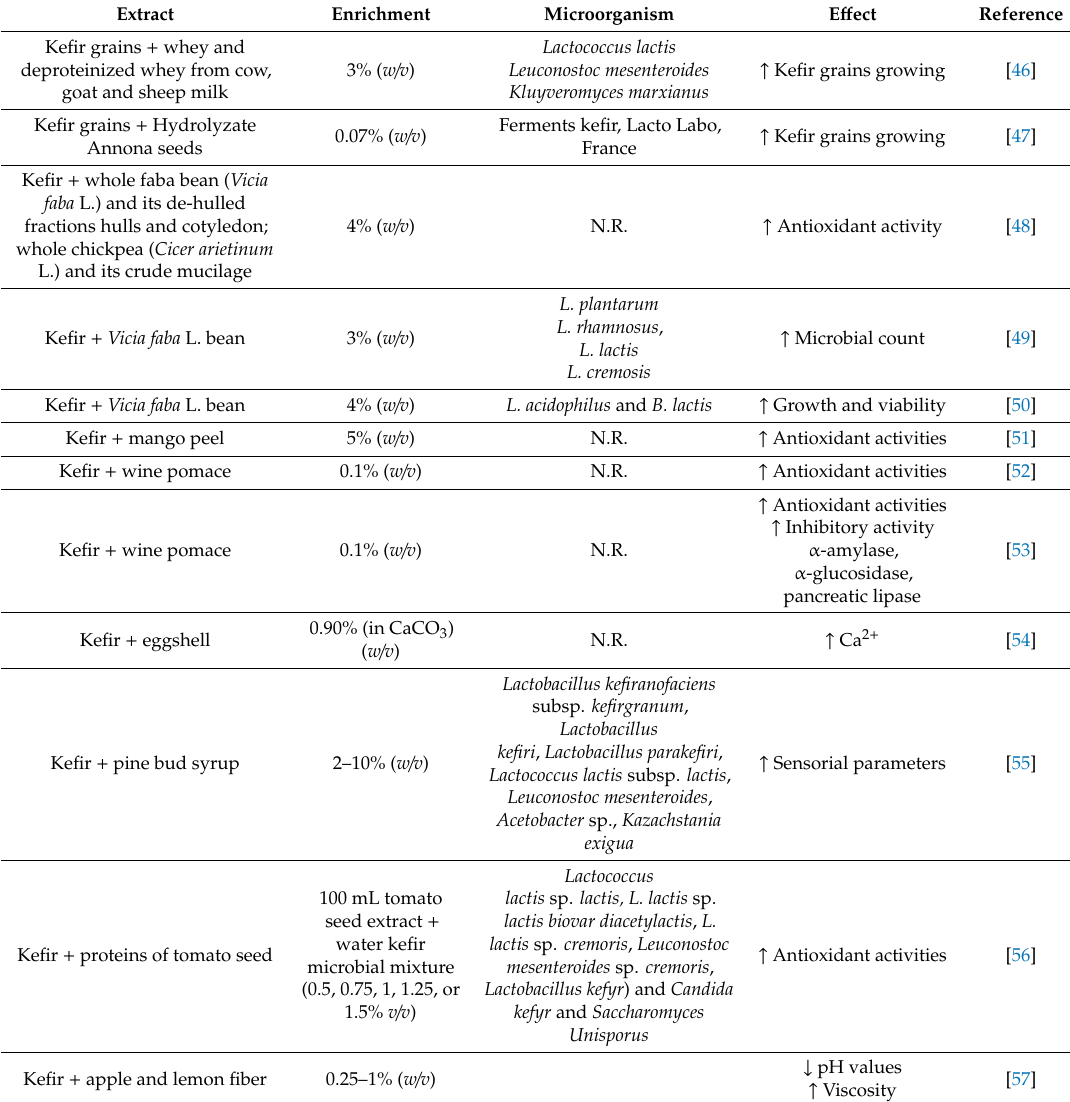
Table 4. Kefir fortification with agro-food waste